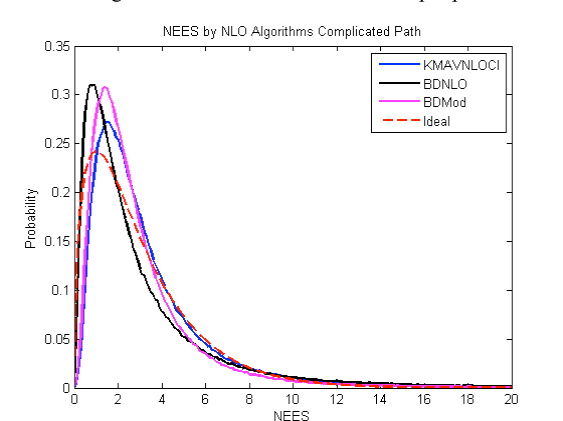
Figure 1. NEES distribution for Simple path